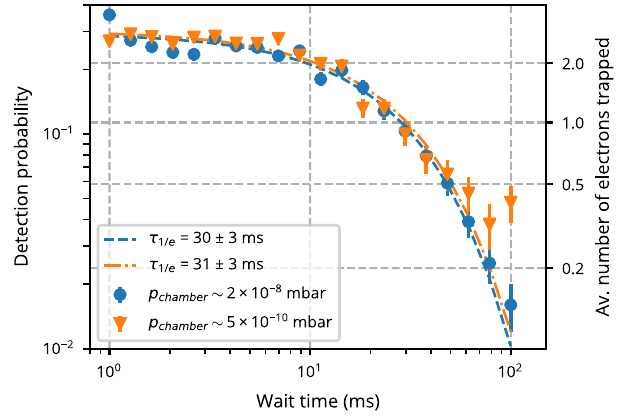
FIG. 8. Electron storage measurements with different back- ground pressure. Data shown as filled circles (fitted by the dashed curve) are taken at typical operating conditions, where the ion pump is switched off. Data shown as triangles (fitted by the dash- dotted curve) are taken at lower chamber pressure, which is achieved by running the ion